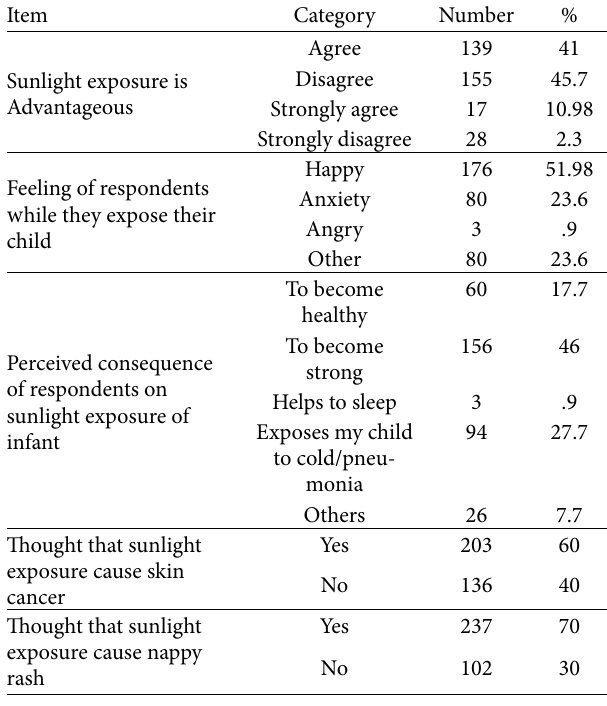
Table 5 : Attitude of respondents on sunlight exposure of infant in Farta Woreda, Northwest Ethiopia,